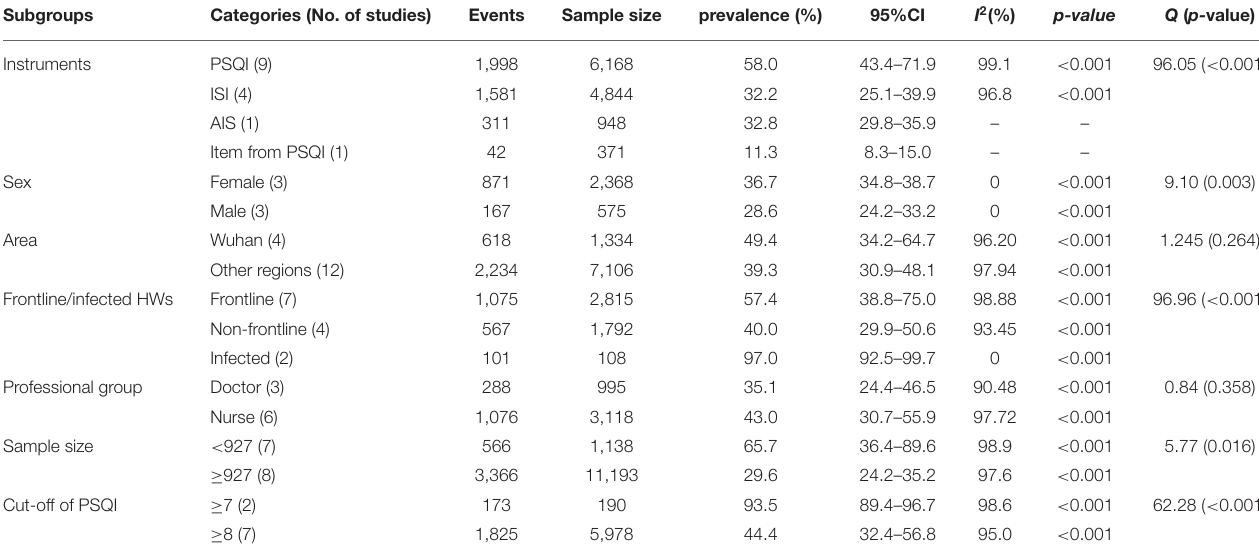
TABLE 2 | Subgroup analyses of the prevalence of sleep disturbances in Chinese healthcare workers.